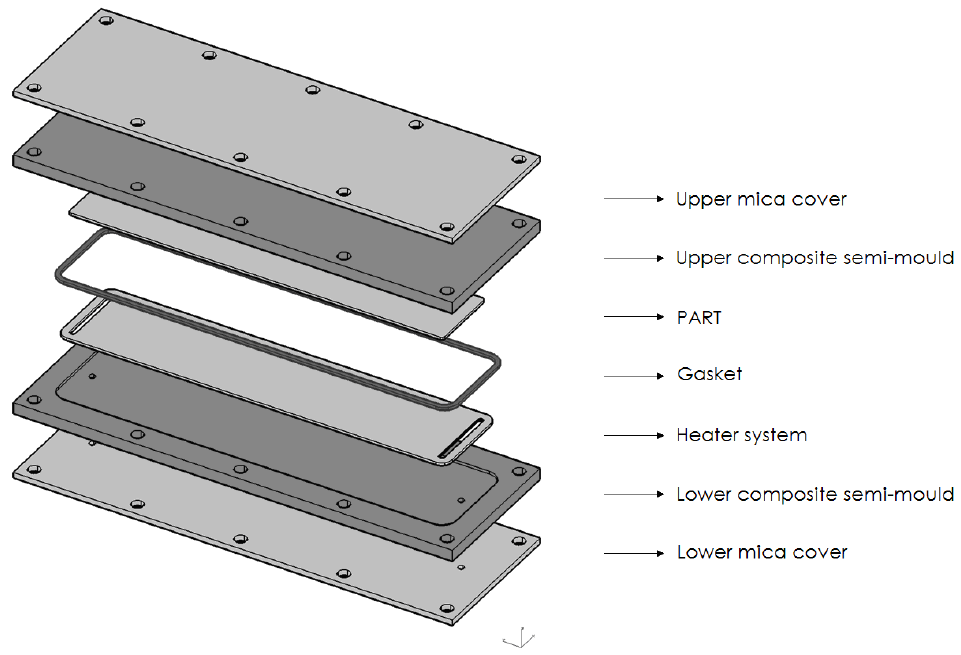
Figure 3. Components of the mould and views of the resulting assembly.